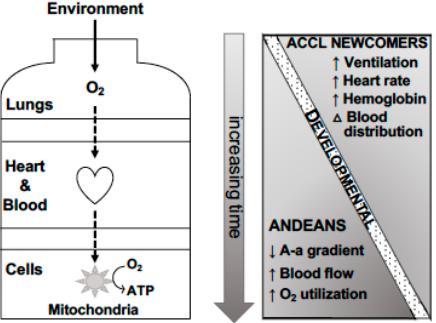
Figure 1. The O 2 transport system and its temporal changes. The O 2 transport system consists of two pumps (the lungs and the heart), two diffusion steps (alveoli to arterial blood, capillary blood to the mitochondria), and the mitochondria where O 2 is consumed to generate chemical energy, adenosine triphosphate (ATP). Increases in the levels of ventilation, heart rate, and hemoglobin as well as changes in blood flow distribution to favor high demand organs occur with acclimatization. Developmental changes increase lung volume. In Andeans, multigenerational high-altitude residence produces further changes in the alveoli to arterial O 2 gradient, regional blood flow, and O 2 utilization. See text for details and references. Adapted from [12].